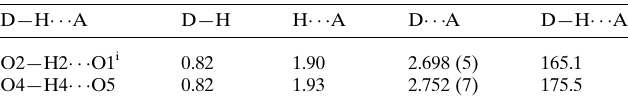
Table 2 Hydrogen-bond geometry (A˚ , (cid:4) ).